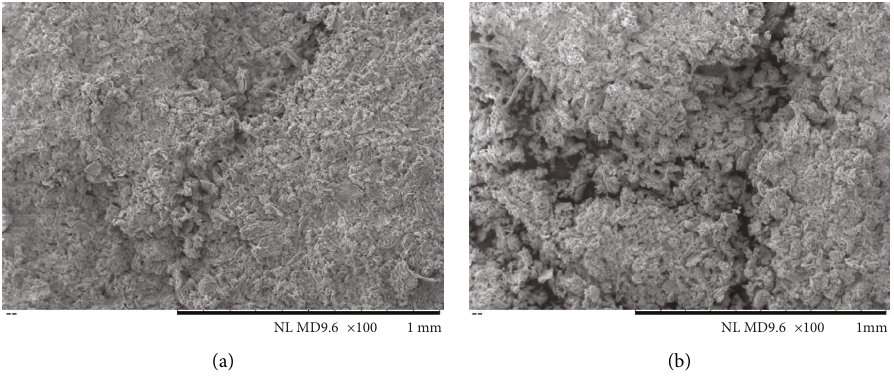
Figure 1: SEM images of (a) untreated raw hibiscus flower powder and (b) pretreated hibiscus flower powder after being soaked for 60min.